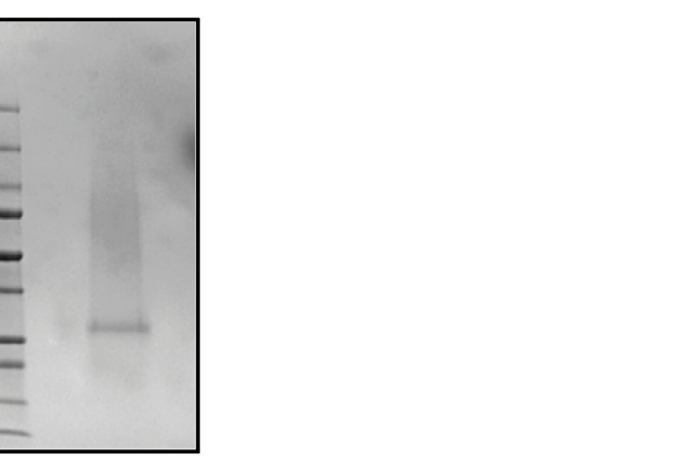
Figure 5. M. balsamina leaf extract was run on an SDS-PAGE gel. The gel was stained in C.B.B. to elucidate any possible proteins in the extract. Only one protein band appeared at approximately 30 kD.